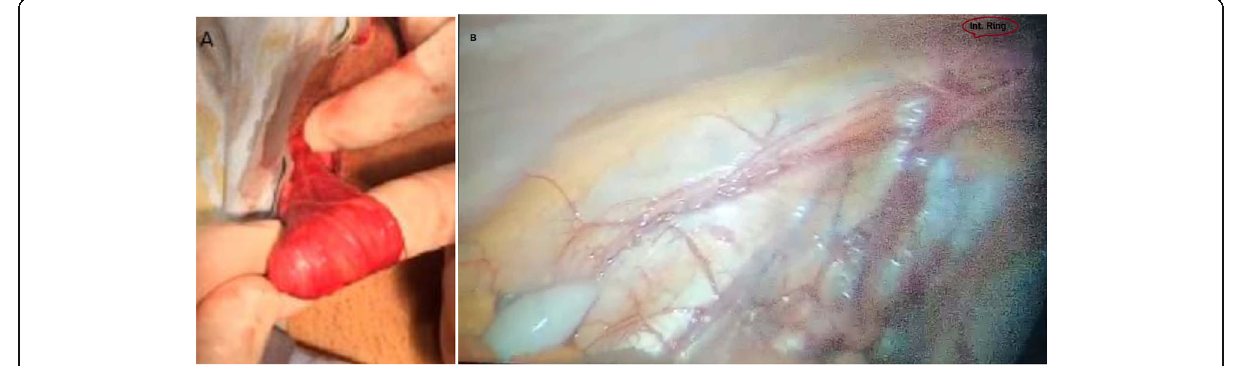
Fig. 13 a Vas deferens agenesis (vessels are present but not the vas deferens). b Congenital absence of the vas deferens